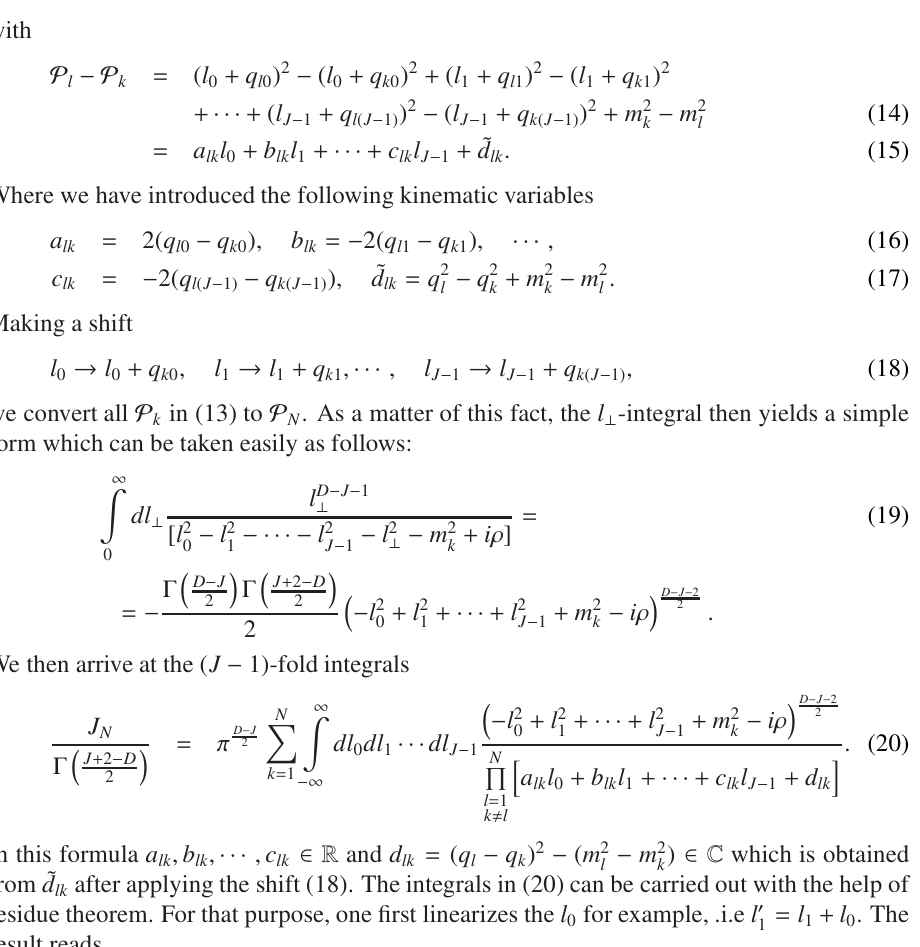
Figure 1. Generic Feynman diagrams at one-loop with N external lines. All external momenta are inward and follow momentum conservation N q N = p j = j = 1 P